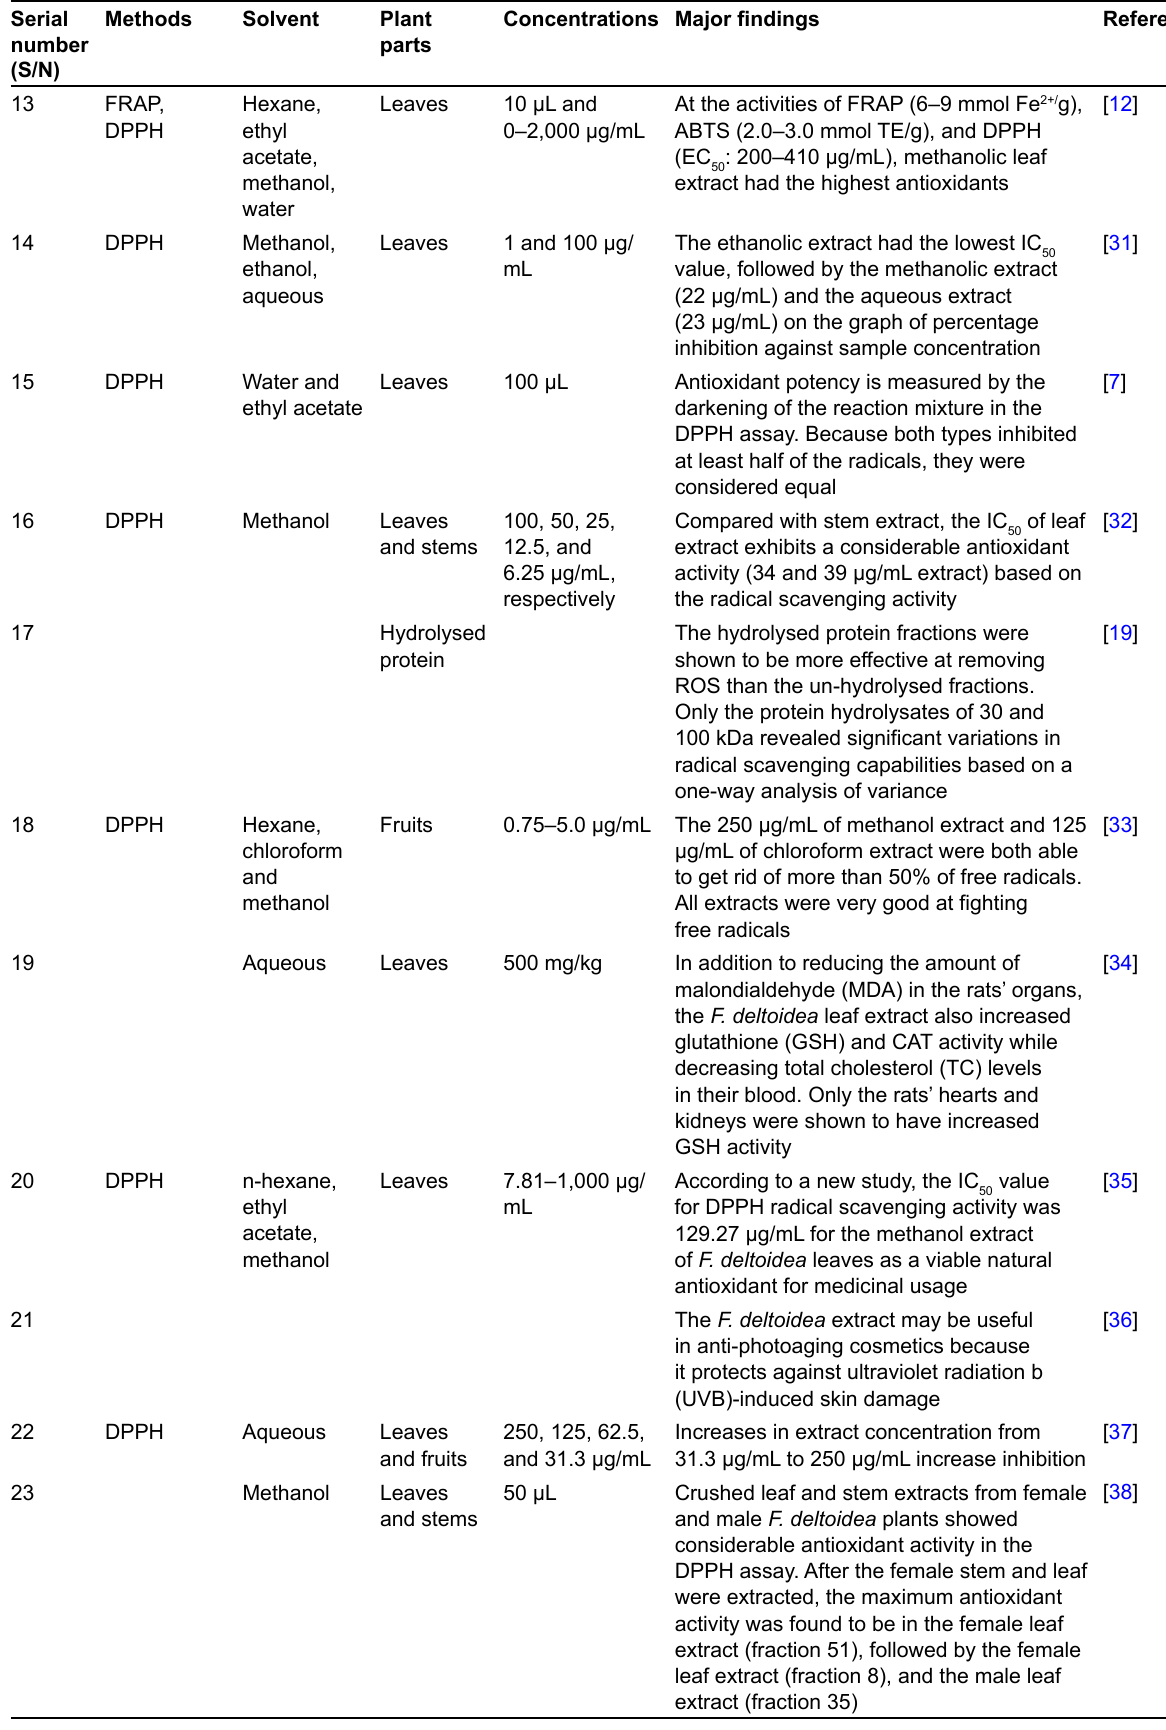
Table 1. Antioxidant activities of FD ( continued